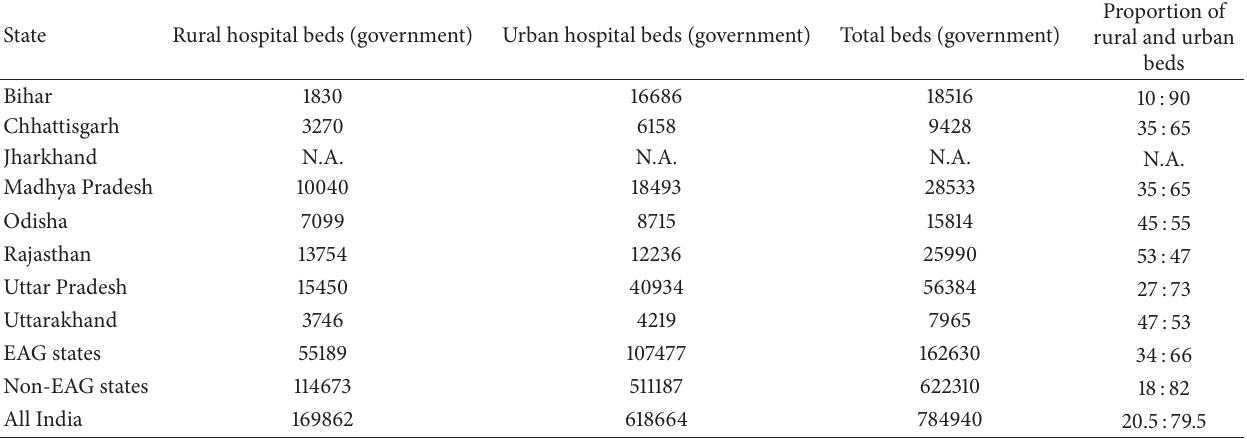
Table 13: Number of government hospital beds in rural and urban